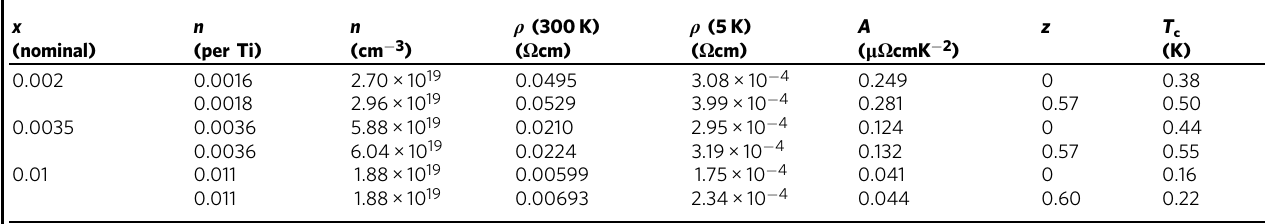
Table 2 Speci fi cations of 18 O-exchanged and 18 O-free single crystals